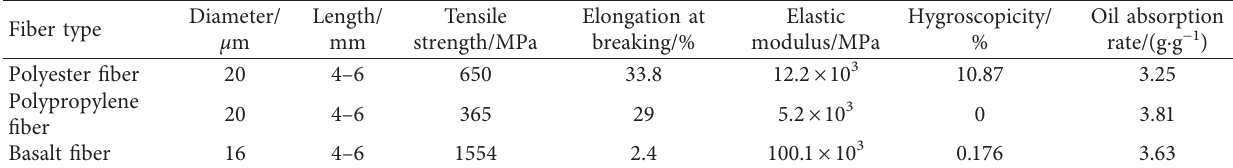
Table 3: The main technical indexes of fiber.